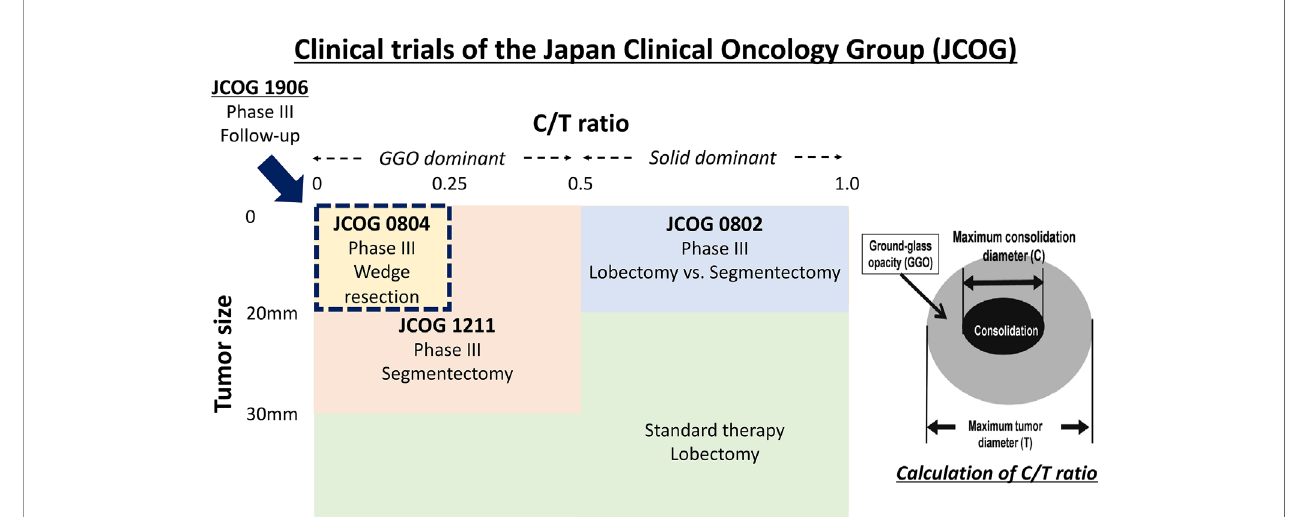
FIGURE 1 | Schema of clinical trials of the Japan Clinical Oncology Group (JCOG)